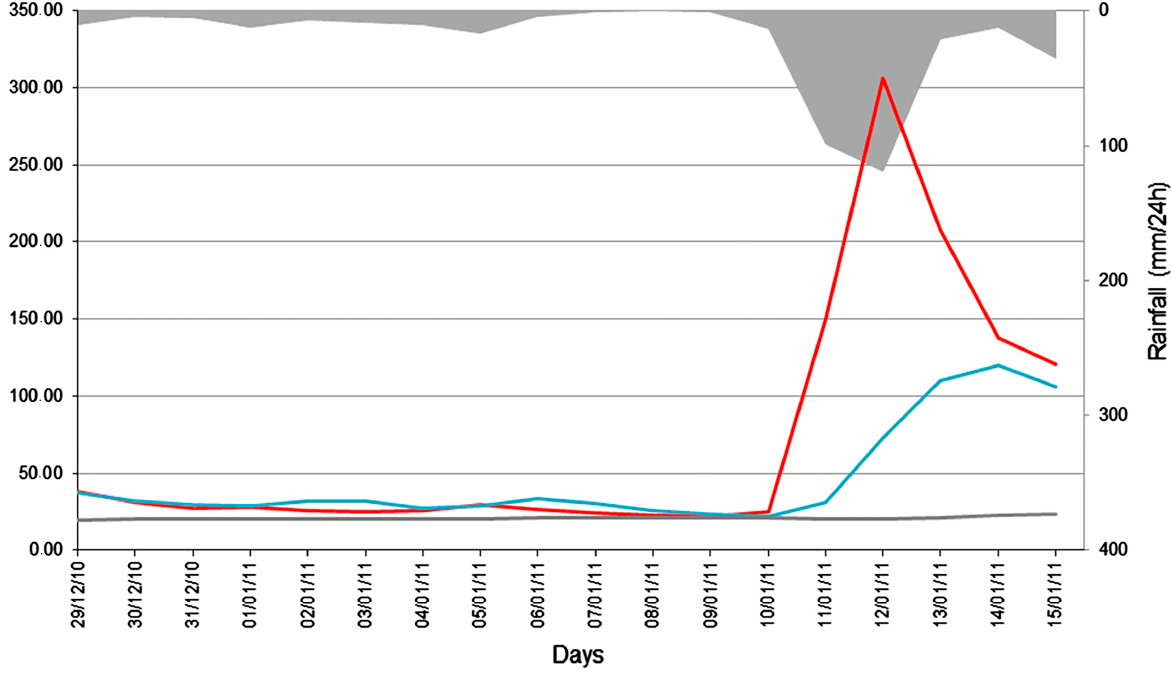
Figure 12. Validation of the SMAP model against the 2011 disaster from the comparison between estimated and simulated flow rates defined by the left axis, while the right axis represents daily precipitation. Source: Reprinted/adapted with permission from Ref. [17]. 2020. Cavalcante, Barcelos and Cataldi.